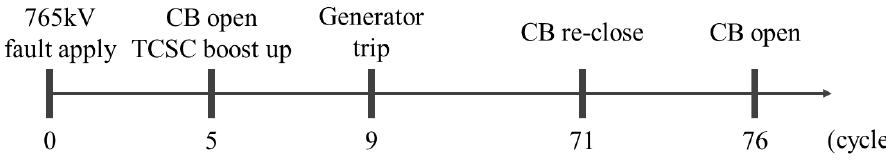
Figure 11. 765 kV line fault sequence considering emergency control and SPS.